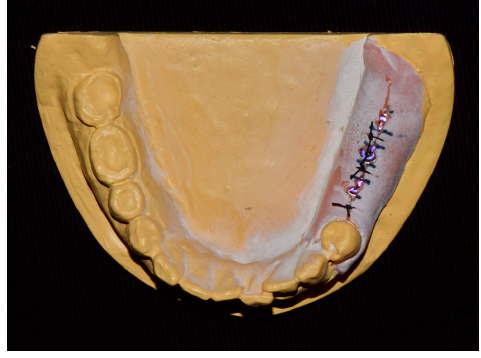
Figure 2. Study model. Figure 2. Study